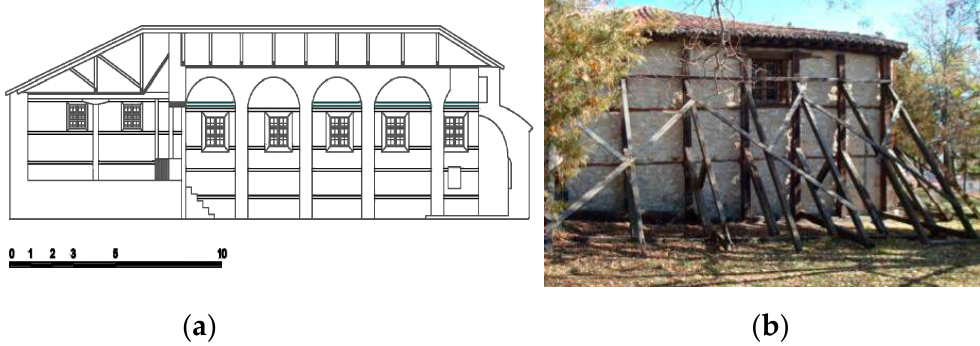
Figure 4. The “Basilica” church of Profitis Ilias at Siatista – Kozani ( a ) Longitudinal cross-section; ( b ) Wooden shoring of South longitudinal wall. ( b ) Wooden shoring of South longitudinal wall.